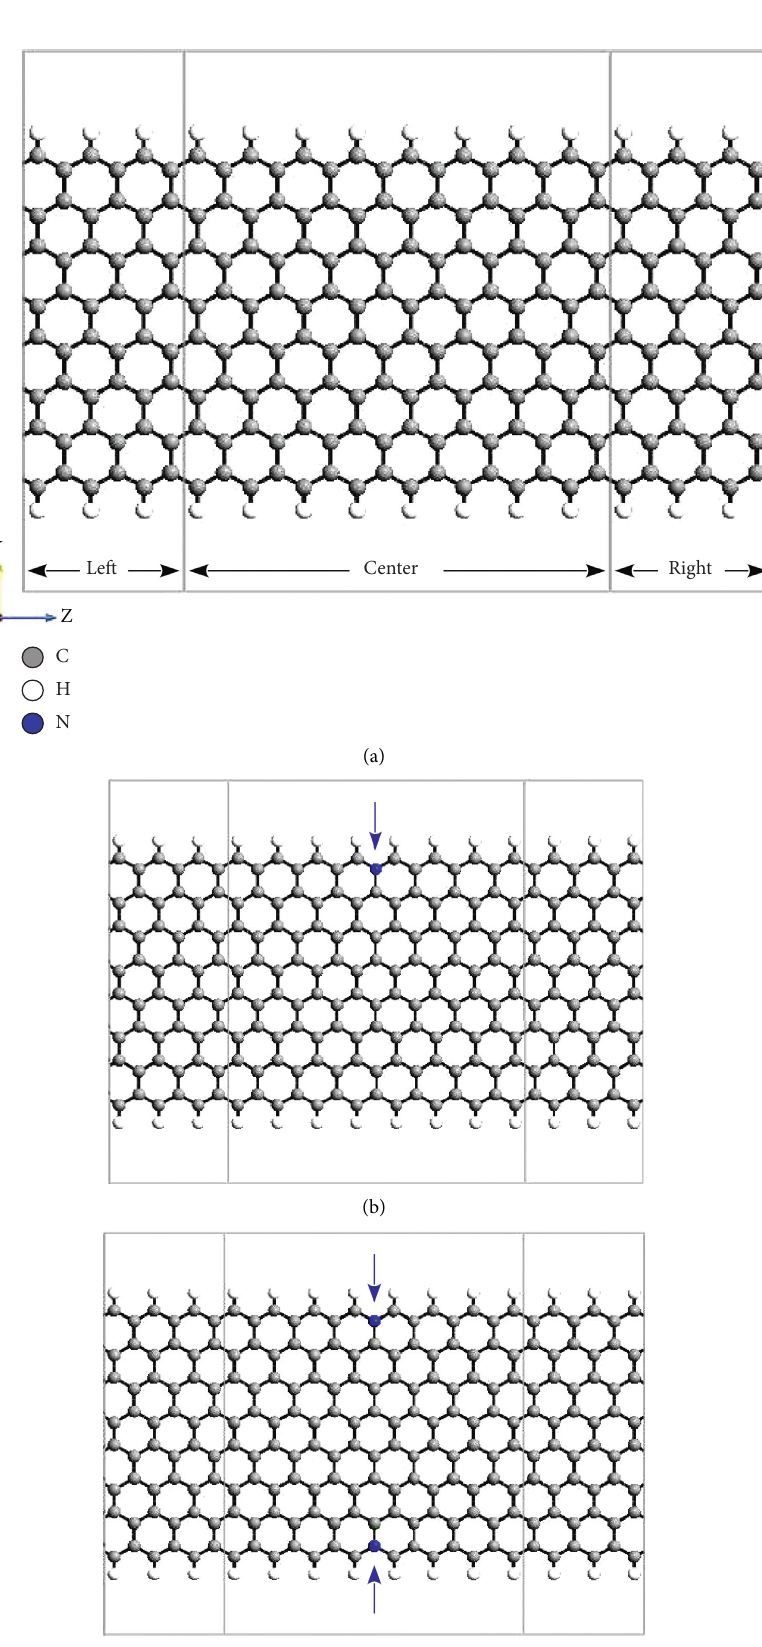
Figure 1: Schematic representation of the ZGNR system. The central region (labeled center) with width w � 8 atoms is connected to semiinfinite ZGNRs (labeled left/right). (a) The unperturbed ZGNR. (b) The ZGNR perturbed with a single N atom (denoted by arrow). (c) The ZGNR perturbed with double N atoms (denoted by